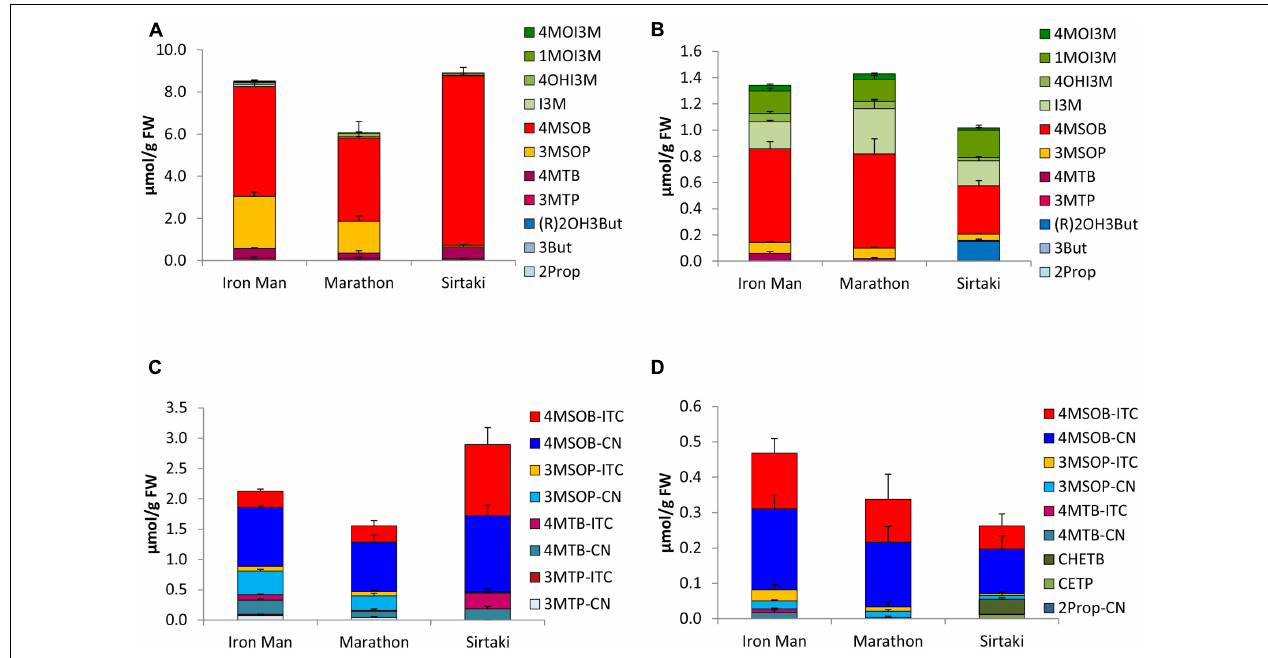
FIGURE 3 | Glucosinolates [ µ mol/g FW] and their hydrolysis products [ µ mol/g FW] in different cultivars of cauliflower in sprouts [ (A) GLSs, (C) hydrolysis products] and fully developed cauliflower heads [ (B) GLSs, (D) hydrolysis products]. Abbreviations: see Table 2 .